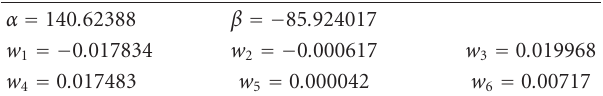
Figure 17: Computation time of the proposed algorithm. Table 7: Method parameters and weighting factors (continuous DMOS scale, 0 to 100).